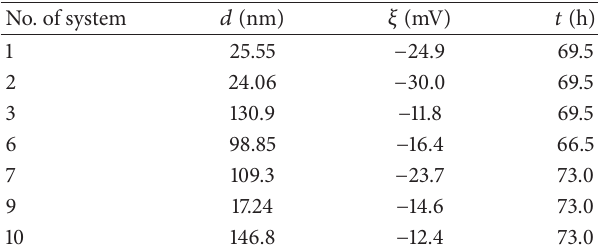
Table 6: Results of the average particle size and stability of the nanogold